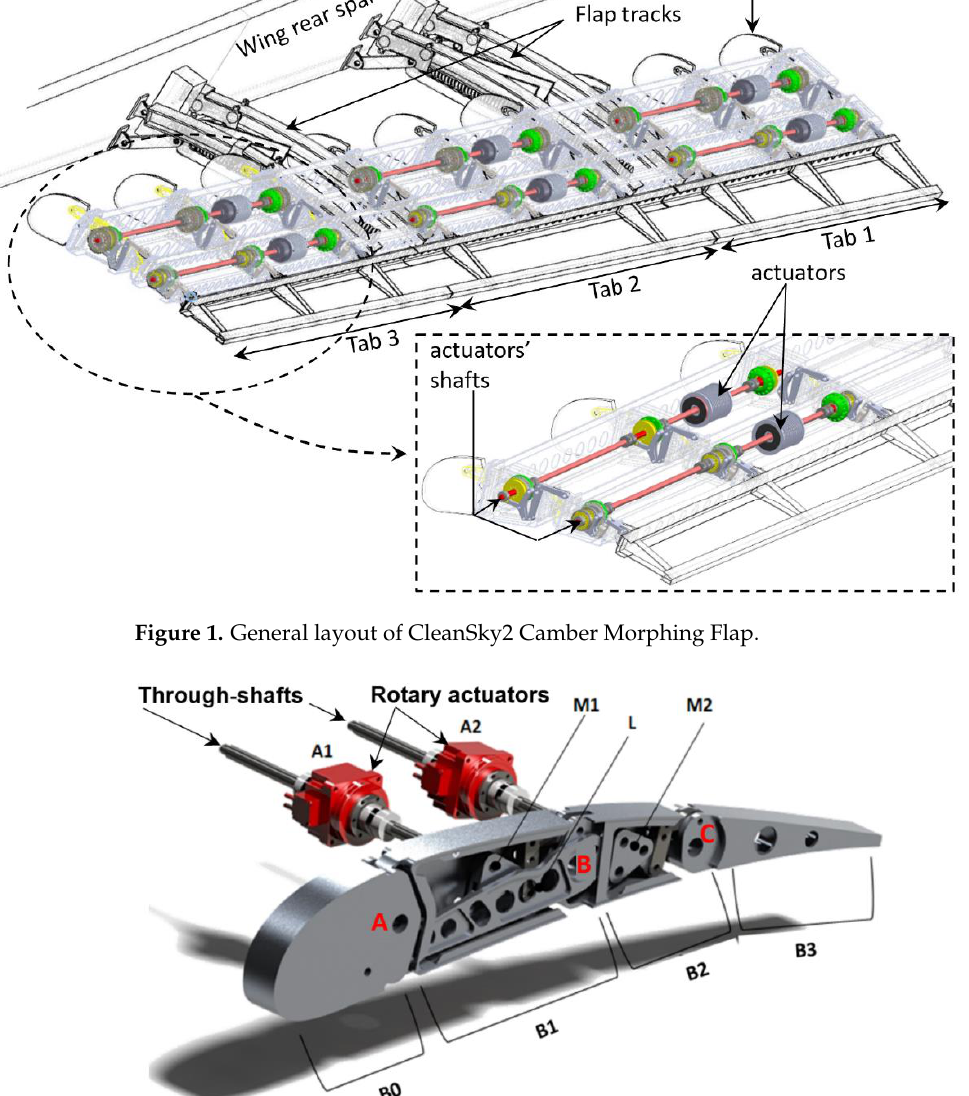
Figure 2. Morphing flap, finger-like robotic rib, and electromechanical actuators. Owing to a through-shaft solution, each couple of actuators drives three (/two) con- secutive ribs (/bays) of the flap (Figure 1). During morphing mode 2 (/3), the amplification mechanism M1 is locked through permanent magnetic brakes, and actuator A1 is pow- ered off; the actuator A2 is then activated, and the torque amplification mechanism M2 induces the upwards/downwards deflection of the rib tip (i.e., the block B3); the actuator shaft rotation and the induced rib tip deflection are constant along the span for mode 2, and step-wise variable along the three flap tabs for morphing mode 3. During morphing mode 1, both the actuators are simultaneously activated; the torque of the actuator A1 is used to move the amplification mechanism M1, which in turn makes the block B2 rotate with respect to the hinge B; since B0, B1, and B2, together with the link L, make a single degree-of-freedom mechanism, the rotation of B2 around B forces the rotation of B1 around A, according to specific gear ratios. The actuator A2 is synchronized to actuator A1 to properly control the deflection of the rib tip according to the positions assumed by blocks B0, B1, and B3, and the morphed shape of the cross-section to be